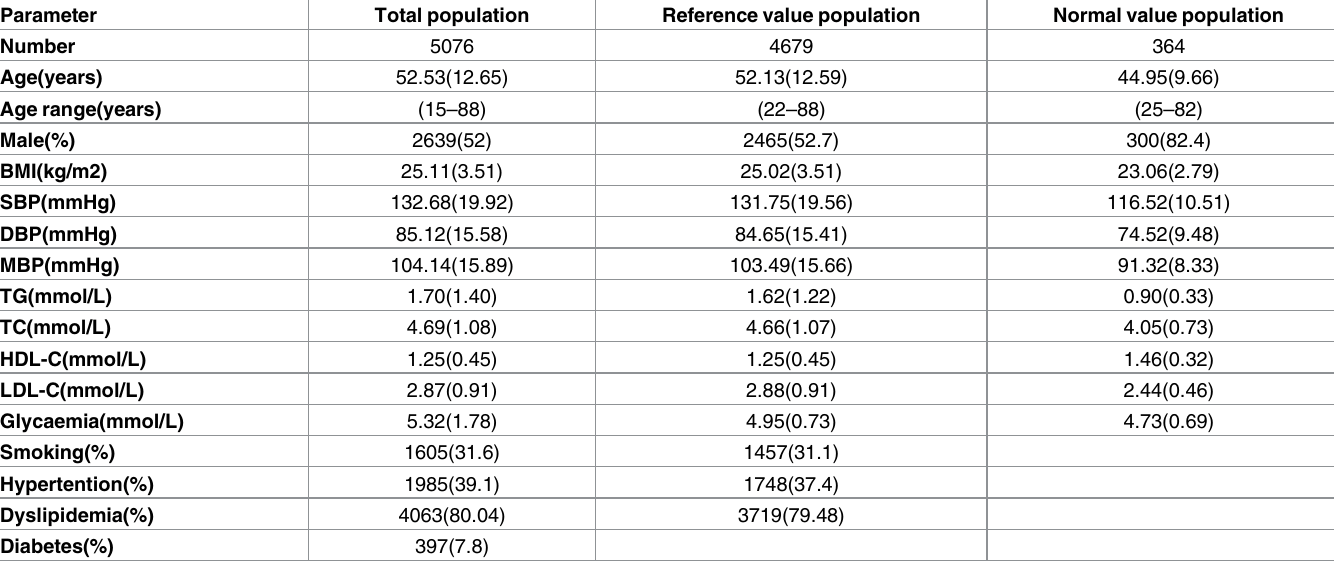
Table 1. Characteristics of study population.